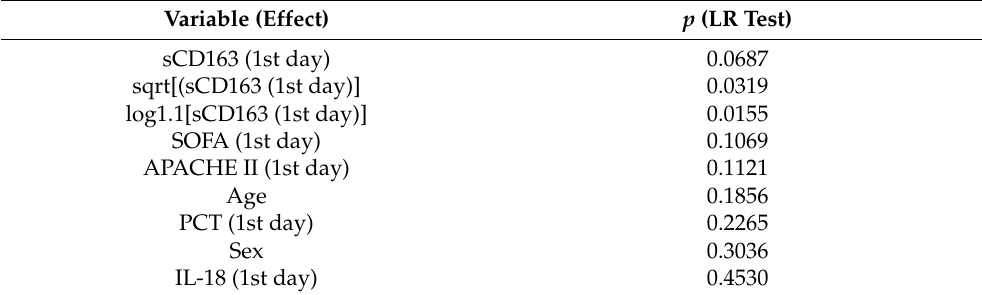
Table A1. Assessment of the association between the selected variables and the risk of in-hospital death in septic patients.